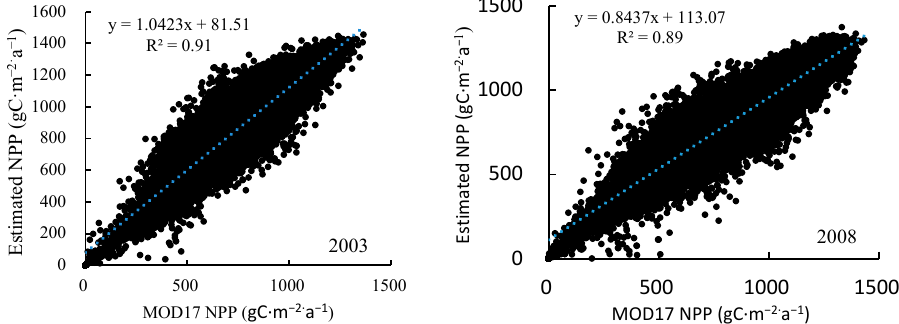
Figure 5. Comparison between simulated NPP and MOD17 NPP, based on different raster pixels, in 2003 and 2008.